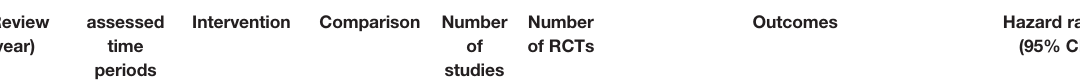
Subgroup analysis: Effect of HIPEC according to different study designs and primary or recurrent